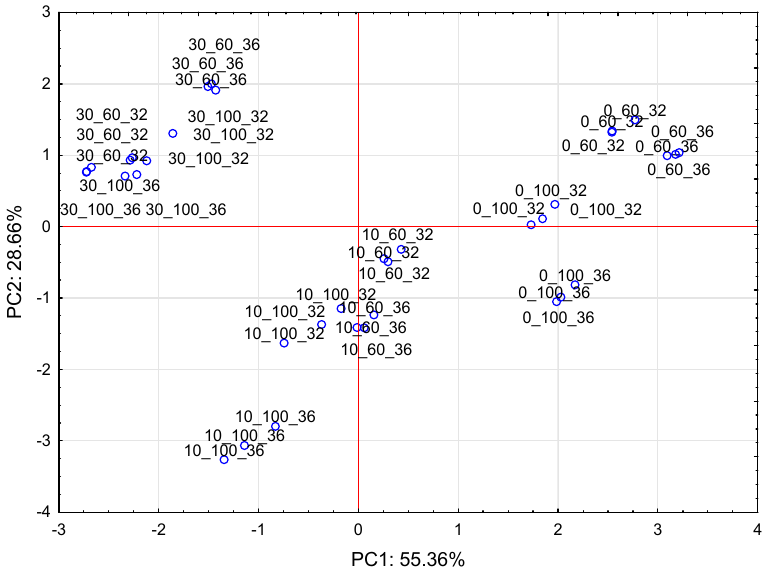
Figure 3. PC1 and PC2 loading plot. Projection of cases characterizing the level of fresh kale addition with screw rotation and